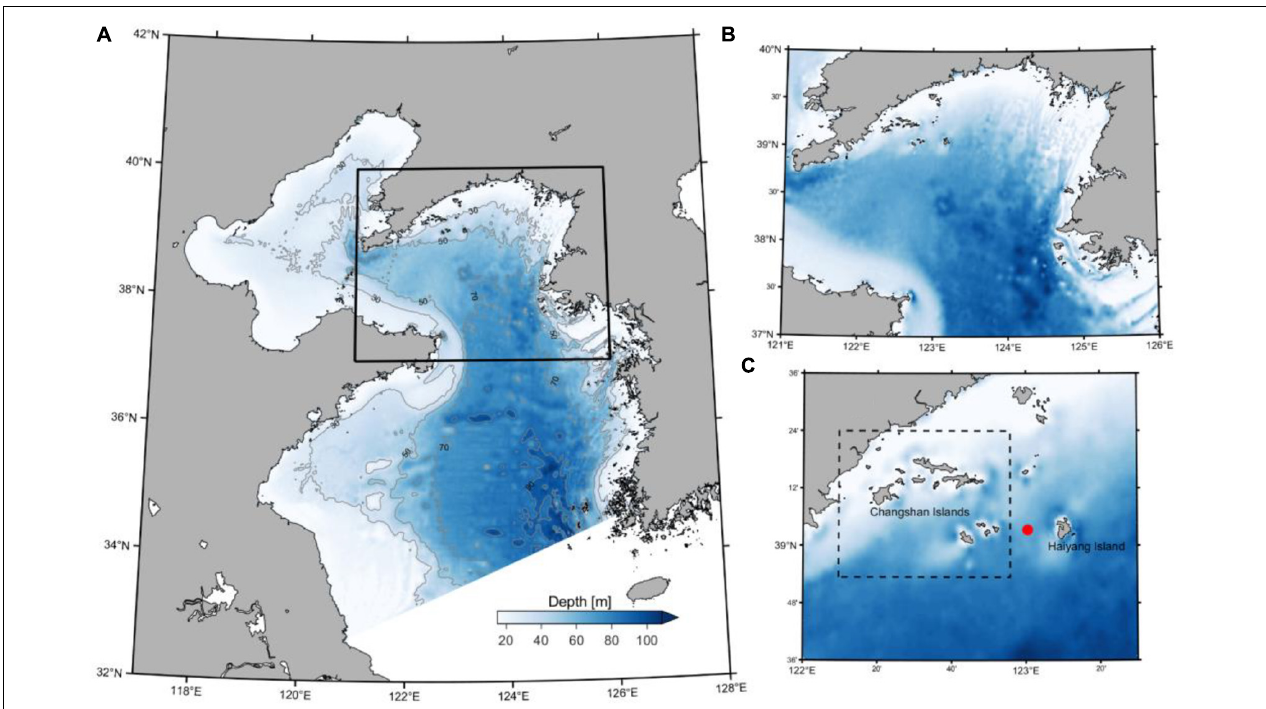
FIGURE 1 | Domain and topography of the Yellow Sea model. (A) Model domain covering the Yellow Sea and Bohai Sea. (B) Major results will be presented from the northern Yellow Sea where the ADCP mooring site is shown as the red dot in (C) . All the subfigures share the same color scale as shown in (A) .